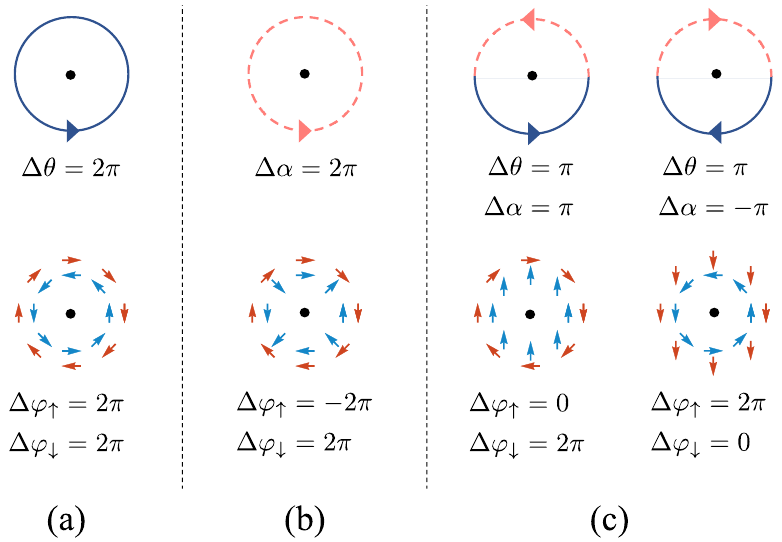
Figure 1: Phase windings of (a) a full-quantum vortex (fqv), (b) a d -vector meron (dm), and (c) half-quantum vortices (hqv), where θ and α represent phases asso- ciated with charge and spin order, respectively, and ϕ σ represent the phase of the spin- σ Cooper pair ∆ σσ = | ∆ σσ | e i ϕ α . A fqv, a dm, and a fqv have U(1) winding numbers ( m c , m sp ) = ( ± 1,0 ) , ( 0, ± 1 ) , and ( ± 1 / 2, ± 1 / 2 ) , respectively, where m c and m sp are the winding numbers associated with θ and α